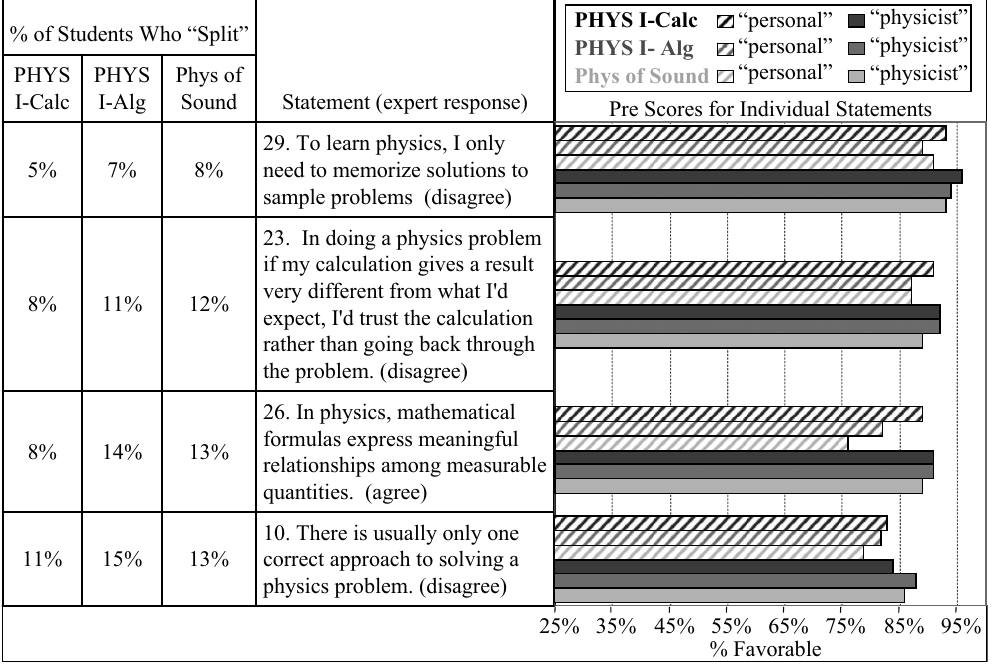
FIG. 5. Statements with the fewest splits in the pre responses. Less than 15% of the students surveyed split on these statements. “Personal” (cid:1) striped bars (cid:2) and “physicist” (cid:1) solid bars (cid:2) percentage favorable scores for these statements show differences of 5% on